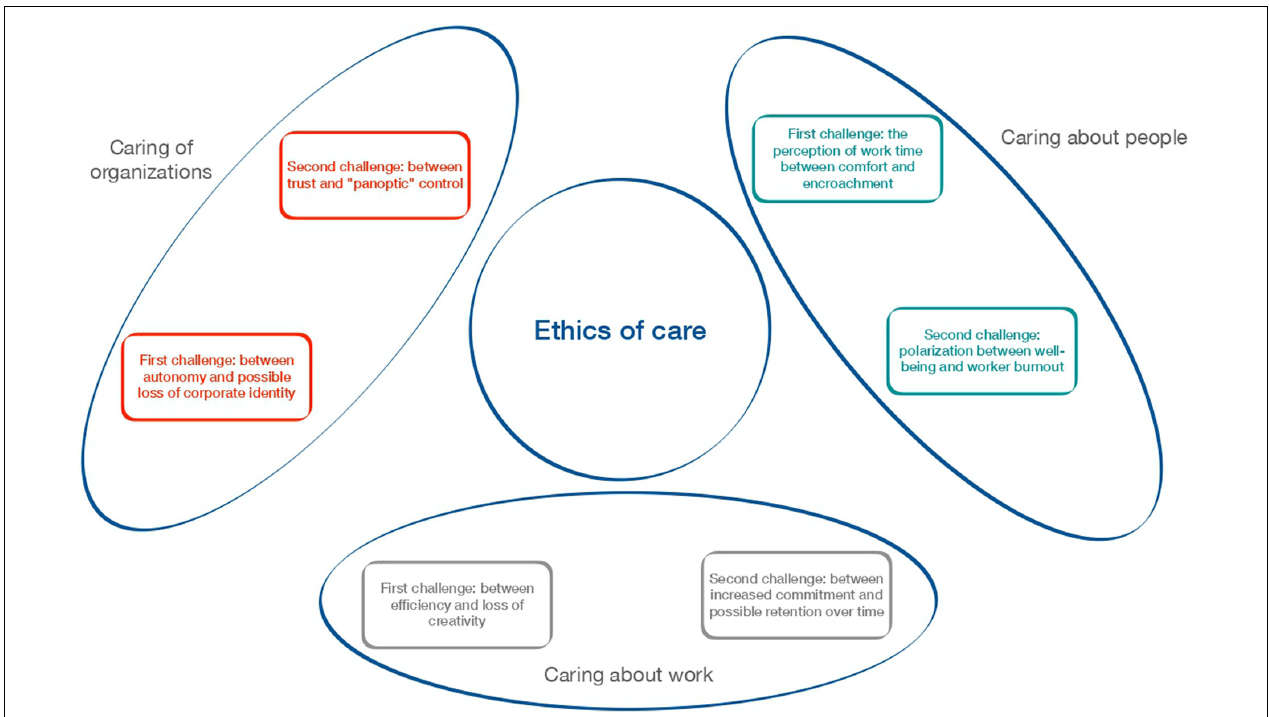
FIGURE 1 | Ethics of